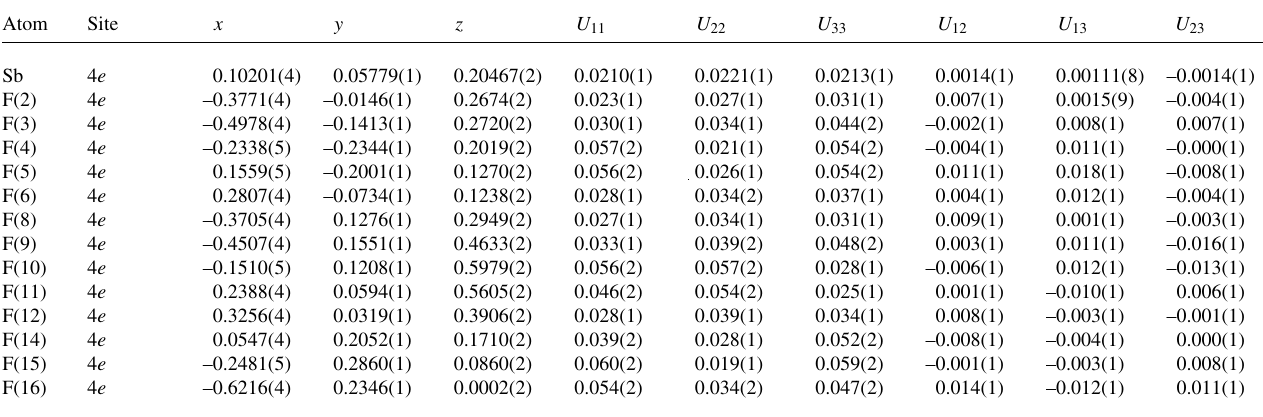
Table 2. Atomic coordinates and displacement parameters (in Å 2 ) .